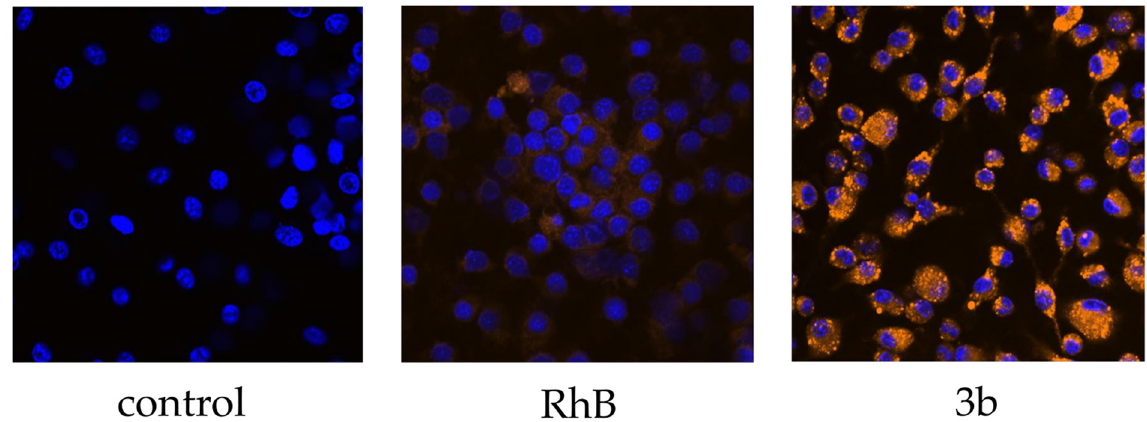
Figure 3. Confocal microscope imaging of mouse bone marrow-derived macrophages untreated (control), treated with solution of free Rhodamine B in concentration 15 µg/mL (RhB) and with formulation 3b representing nanospheres fabricated from branched PLGA using NPM. Cells were incubated with the samples for 1 h. The nuclei were stained by dye Hoechst 33342. Magnification 40× was used.